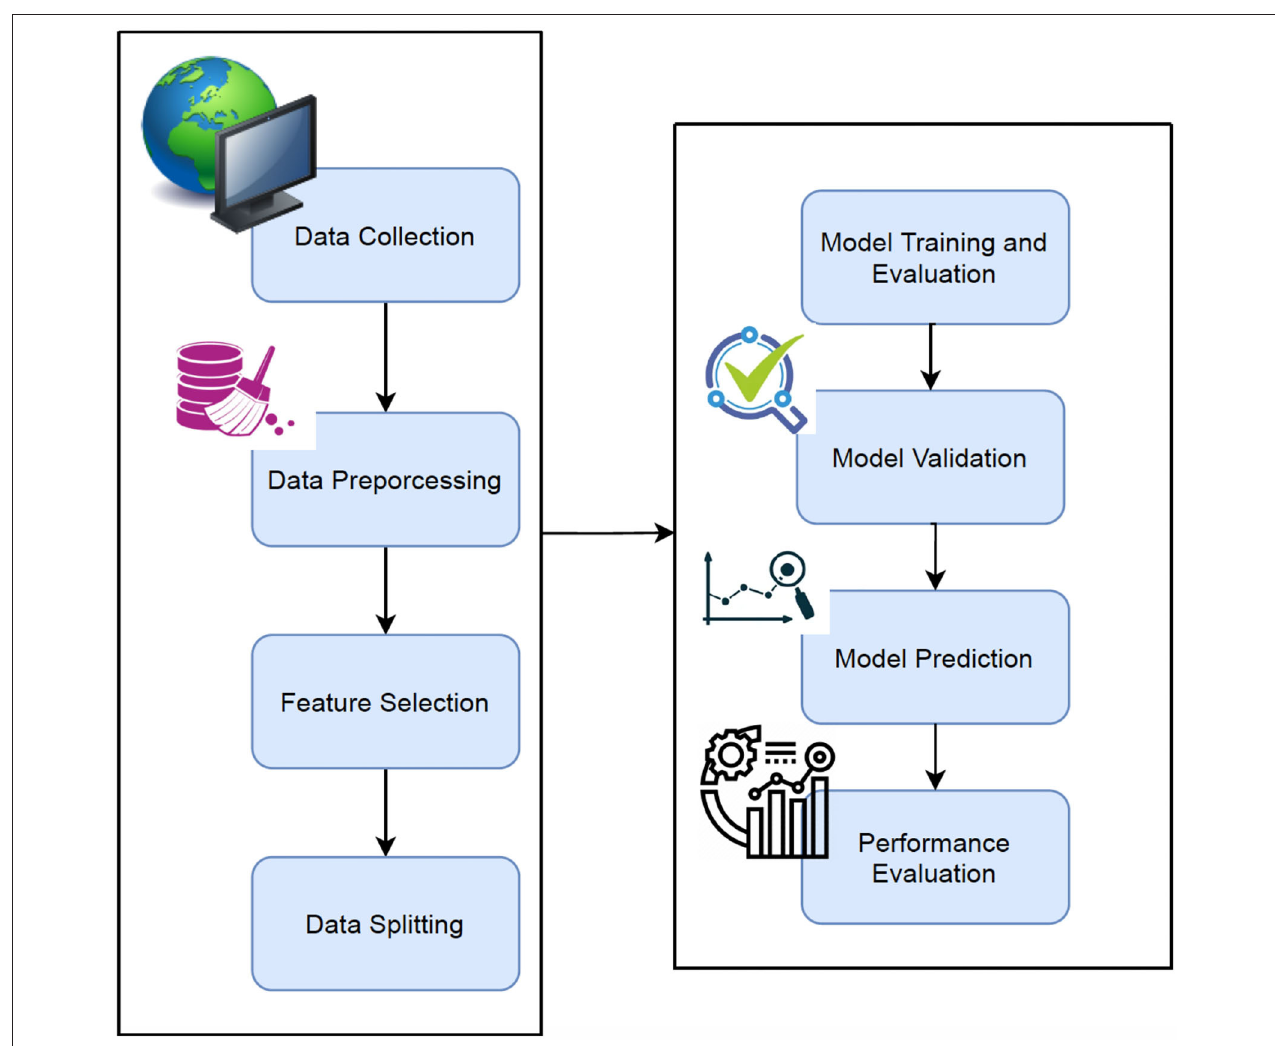
FIGURE 1 | Proposed